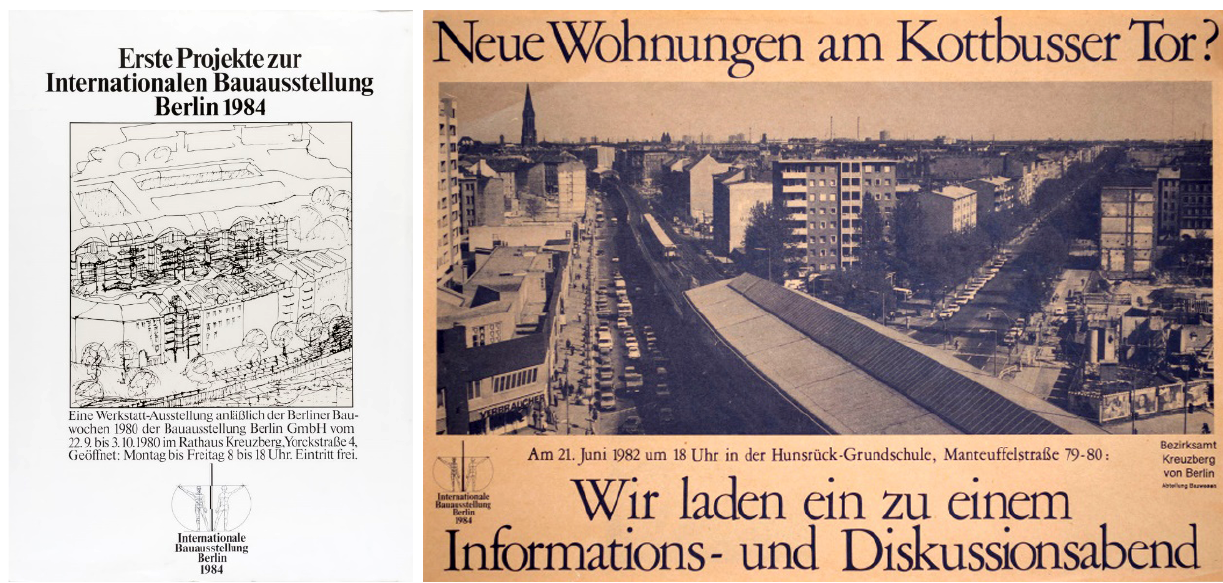
Figure 3. From left to right: Posters of the international planning exhibition in Kreuzberg inviting the public to a